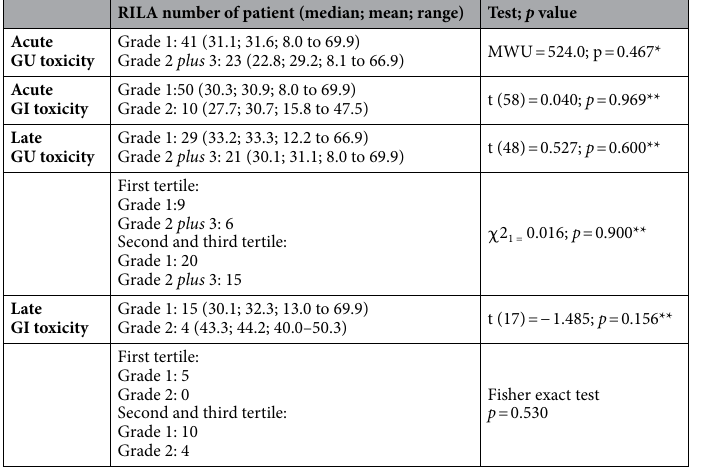
Table 4. RILA and RT-induced toxicity. *Wilcoxon rank sum test; **t test. MWU- Mann–Whitney U Statistic. NA- not applicable. GU- genitourinary; GI- gastrointestinal.